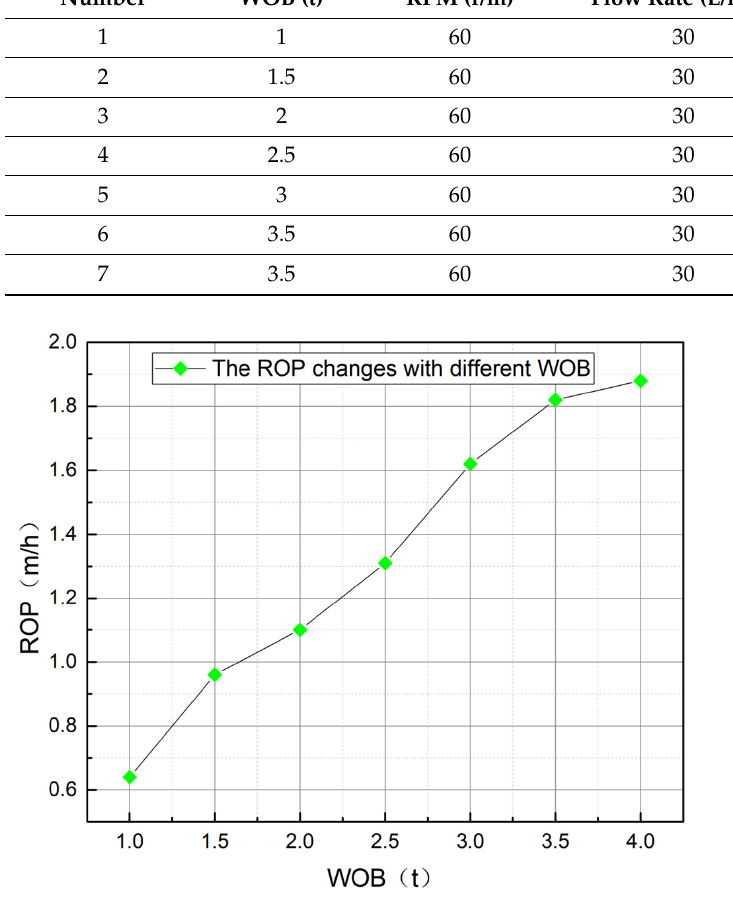
Figure 12. Relationship between WOB and ROP.